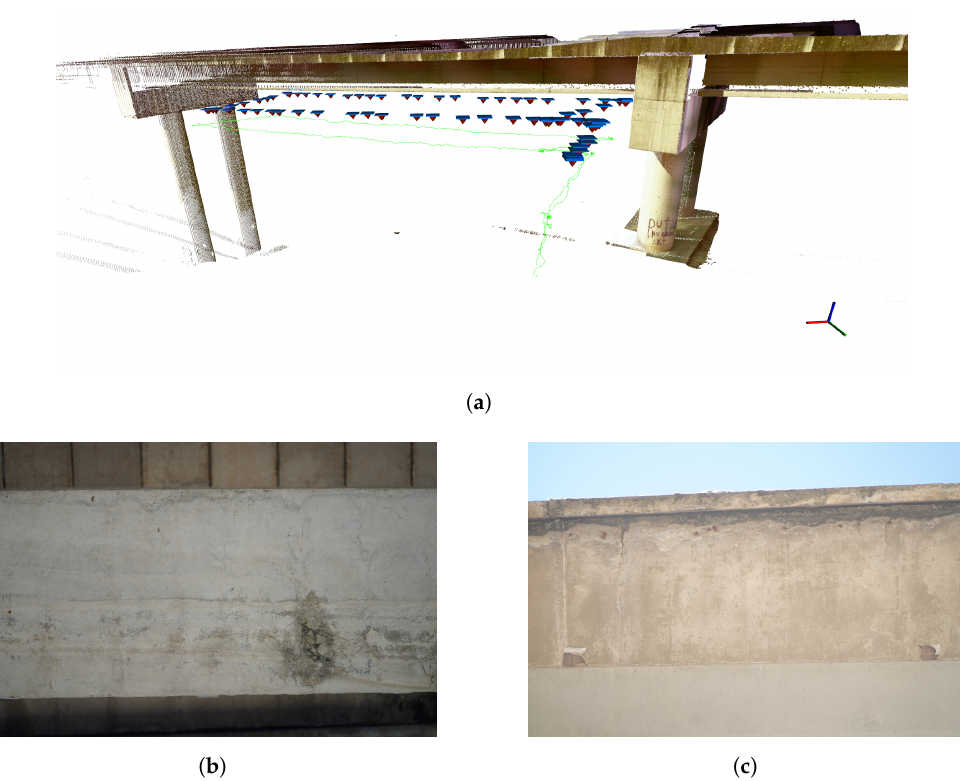
Figure 12. Algodonales sequence 2 inspection result. ( a ) shows the 3D model with the followed route (green) and the location of the acquired pictures (blue planes). ( b , c ) show two examples of the acquired